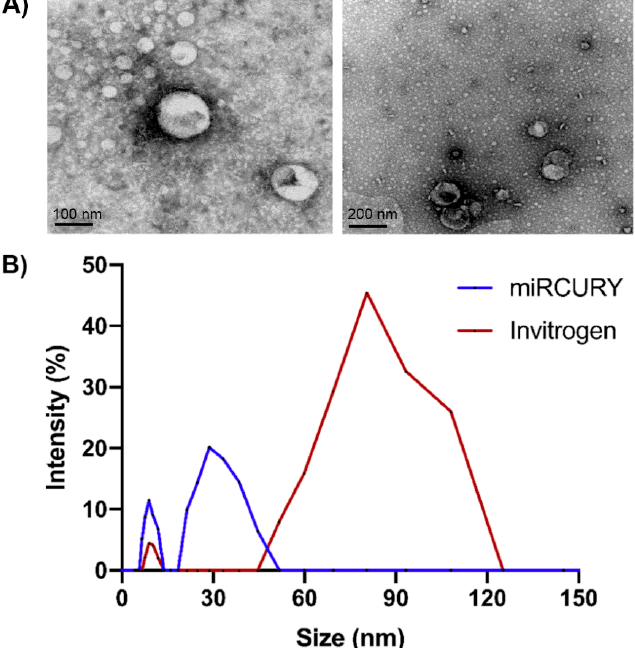
Figure 1. ( A ) Characterisation of sEVs derived from cerebrospinal fluid by transmission electron microscopy (TEM). Images show the presence of small spheres smaller than 200 nm, obtained with Invitrogen isolation kit (left, 100 nm bar) and Exiqon isolation kit (right, 200 nm bar). ( B ) Charac- terisation of sEV derived from blood plasma by dynamic light scattering (DLS). Graph shows that vesicles isolated from plasma displayed a mean diameter ranging between 30 and 120 nm. Intensity profiles showed that the major sEV population was approximately 50–120 nm in diameter (Invitrogen kit) and a second minor population was approximately 20–50nm (Exiqon miRCURY